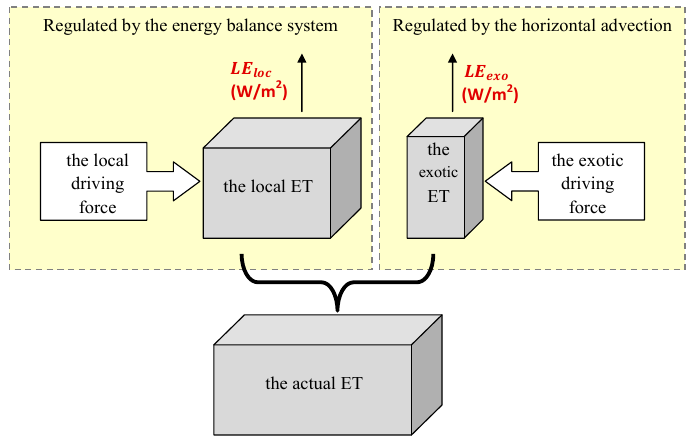
Figure 2. The principle of the surface energy balance-advection (SEB-A) method.